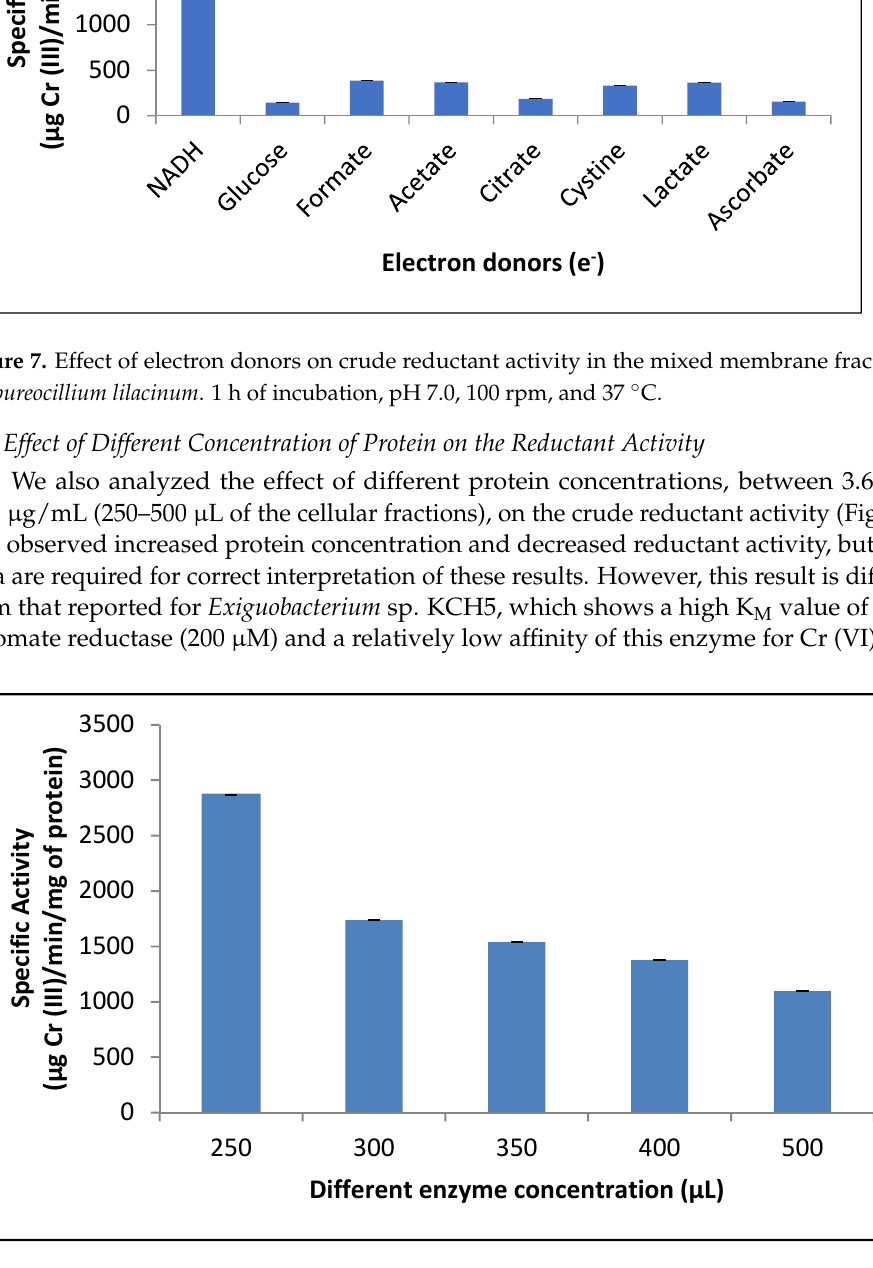
Table 2. FTIR spectrum analysis of the subcellular fraction before and after treatment with 20 mg/L of Cr (VI).